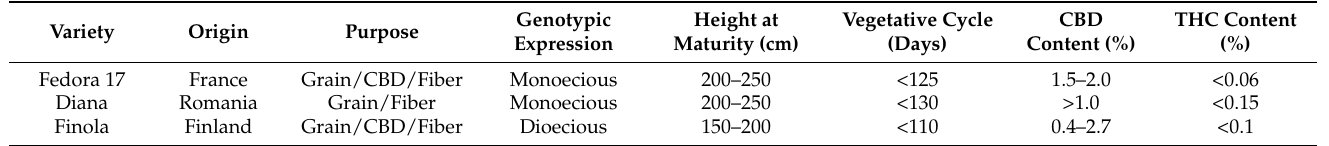
Table 1. Breeding information on tested hemp